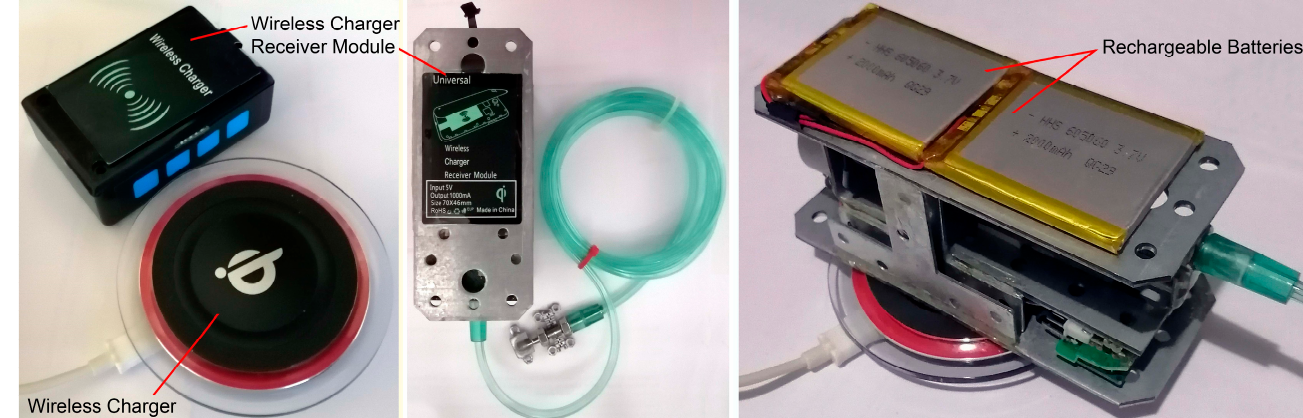
Figure 7. The wireless power charging system.